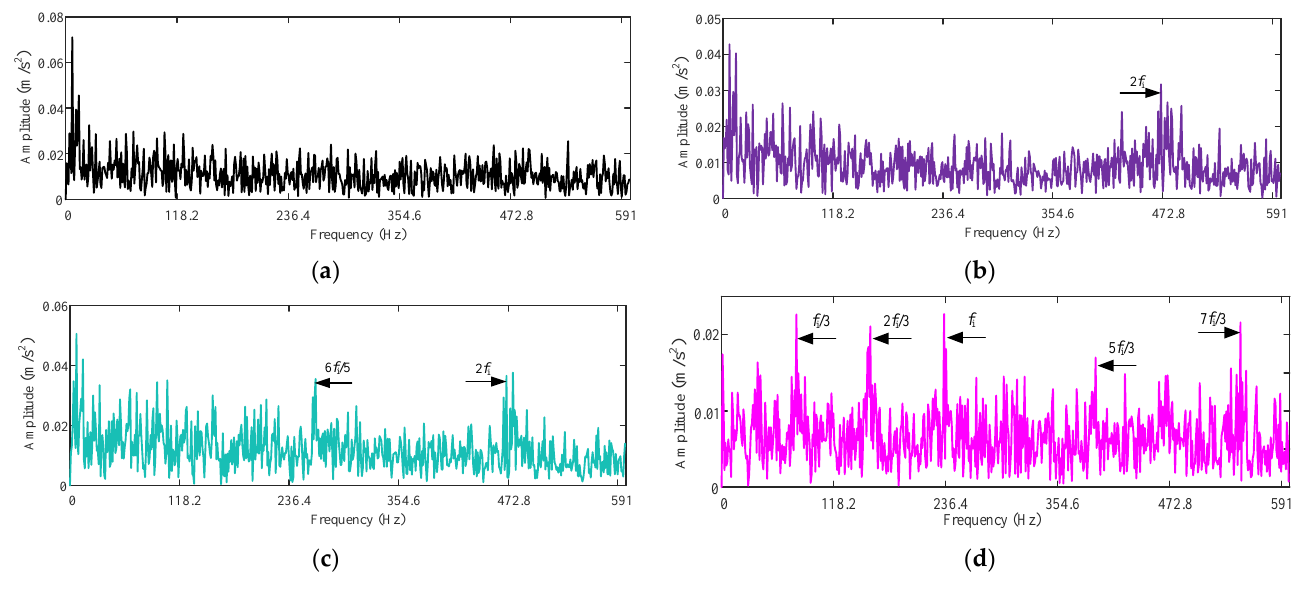
Figure 12. The envelope spectrum of the noise reduction vibration signal obtained by EEMD, VMD, WPD, and the proposed method in Case 1. ( a ) EEMD; ( b ) VMD; ( c ) WPD; ( d ) The proposed method.